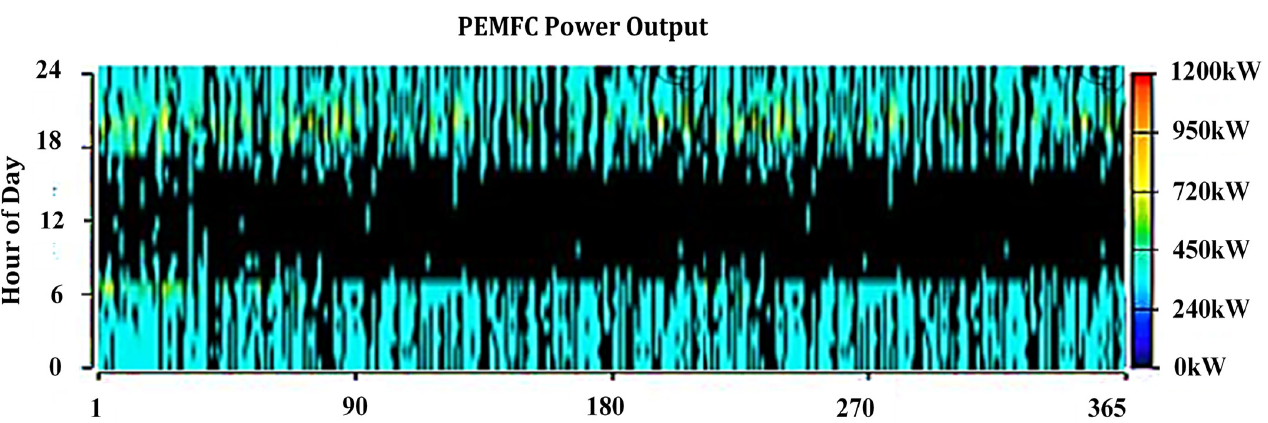
Figure 23. Annual PEMFC generator operation.